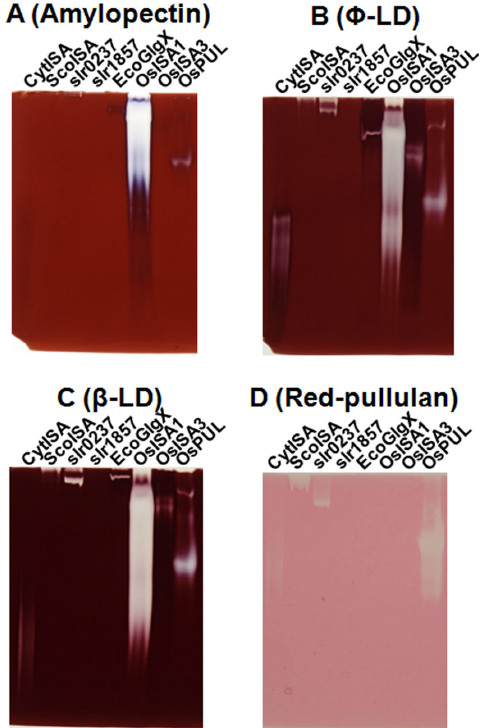
Fig 10. Native-PAGE/staining of activities of DBEs toward amylopetin, Φ -limit dextrins, β -limit dextrins, and red-pullulan. Hydrolytic activities of OsISA1, OsISA3, rice pullulanase (OsPUL), CytISA, ScoISA, Synechocystis sp. PCC6803 ISA slr0237, slr1857, and EcoGlgX were visualized by the native PAGE/activity staining method using a polyacrylamide gel including amylopectin (A), phosphorylase a-limit dextrin from rice amylopectin ( Φ -LD) (B), β -amylase-limit dextrin from rice amylopectin ( β -LD) (C) or red- pullulan